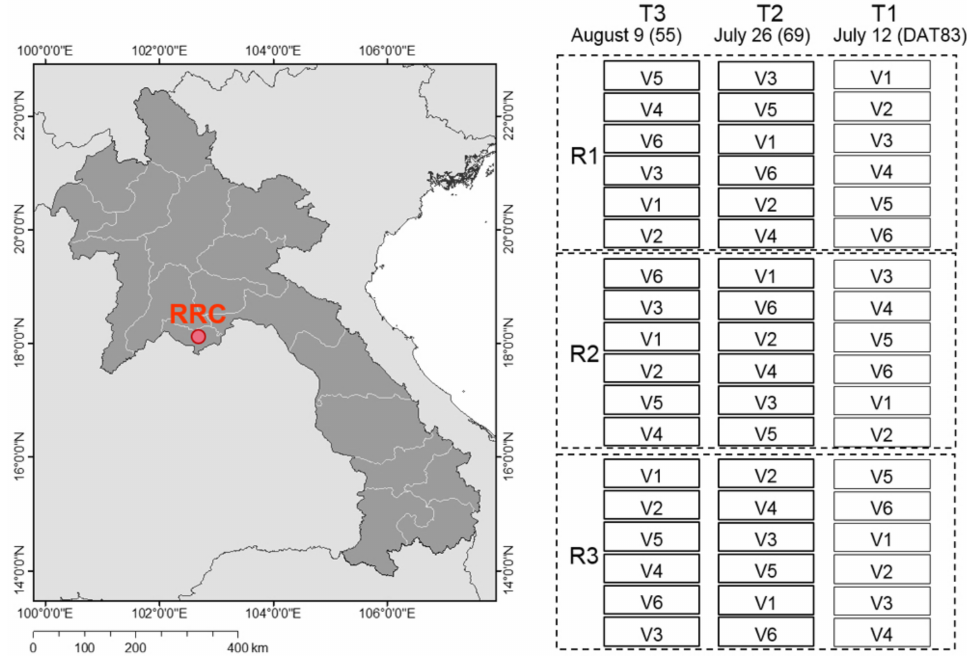
Figure 1. Location of the experimental field at the Rice Research Center (RRC) of the National Agriculture and Forestry Research Institute (NAFRI), and the plot design. V1–V6: Rice varieties (TDK8, TDK11, TSN7, HSV, KPB, and KKK); R1–R3: Three replicates; T1–T3: Transplanting date (12, 26 July and 9 August 2017); DAT: Days after transplanting until the canopy reflectance measurement on 2 October